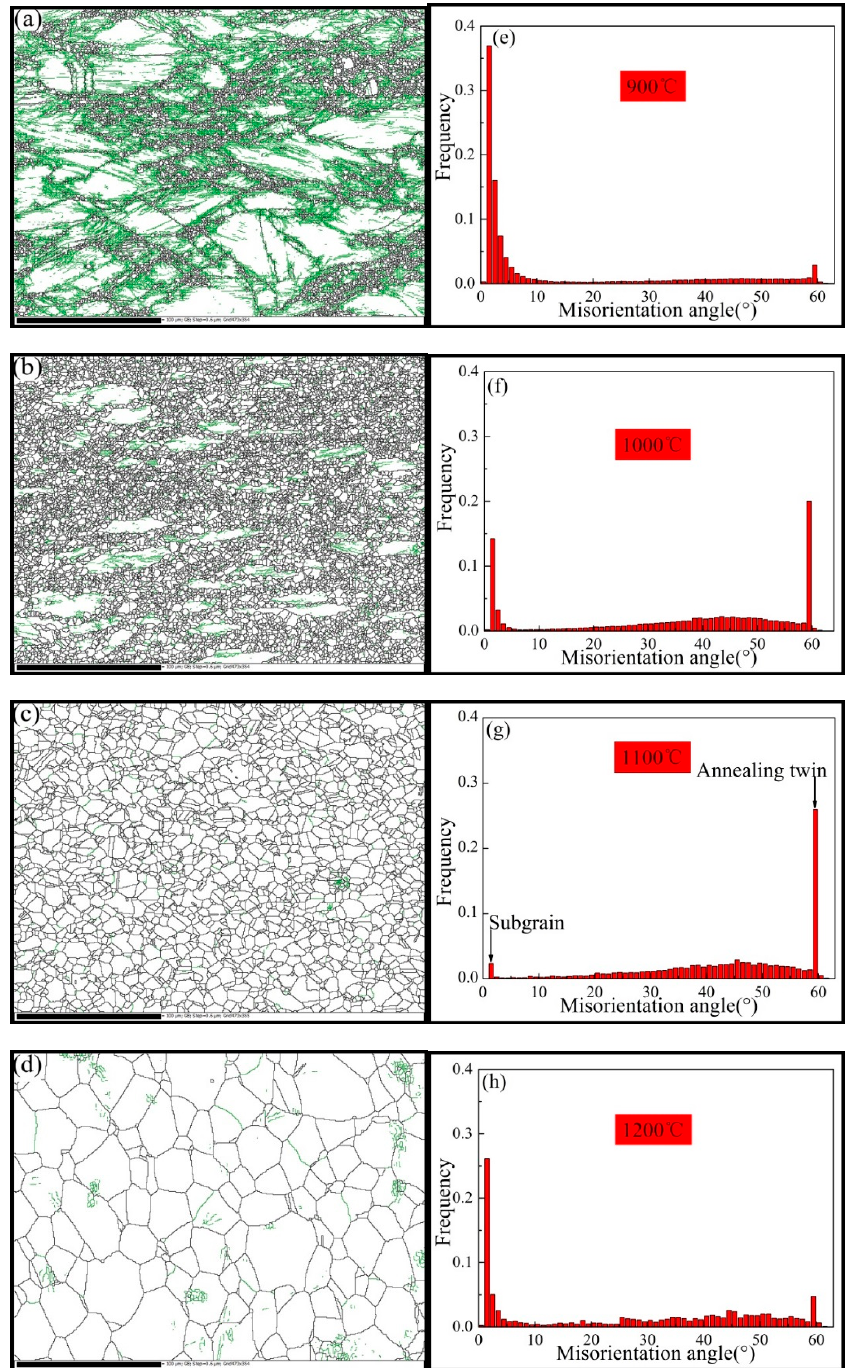
Figure 7. Grain boundary distributions and the correlated grain misorientation angles at different temperatures. ( a,e ) 900 °C; ( b,f ) 1000 °C; ( c,g ) 1100 °C; ( d,h ) 1200 °C. The proportions of the high-angle boundaries were 26% at 900 °C, 78% at 1000 °C, 93% at 1100 °C, and 58% at 1200 °C, as shown in Figure 8. Again, this illustrated the dynamic recrystallization process of the Inconel625 alloy at a high strain rate. As the temperature increased, the rate of dynamic